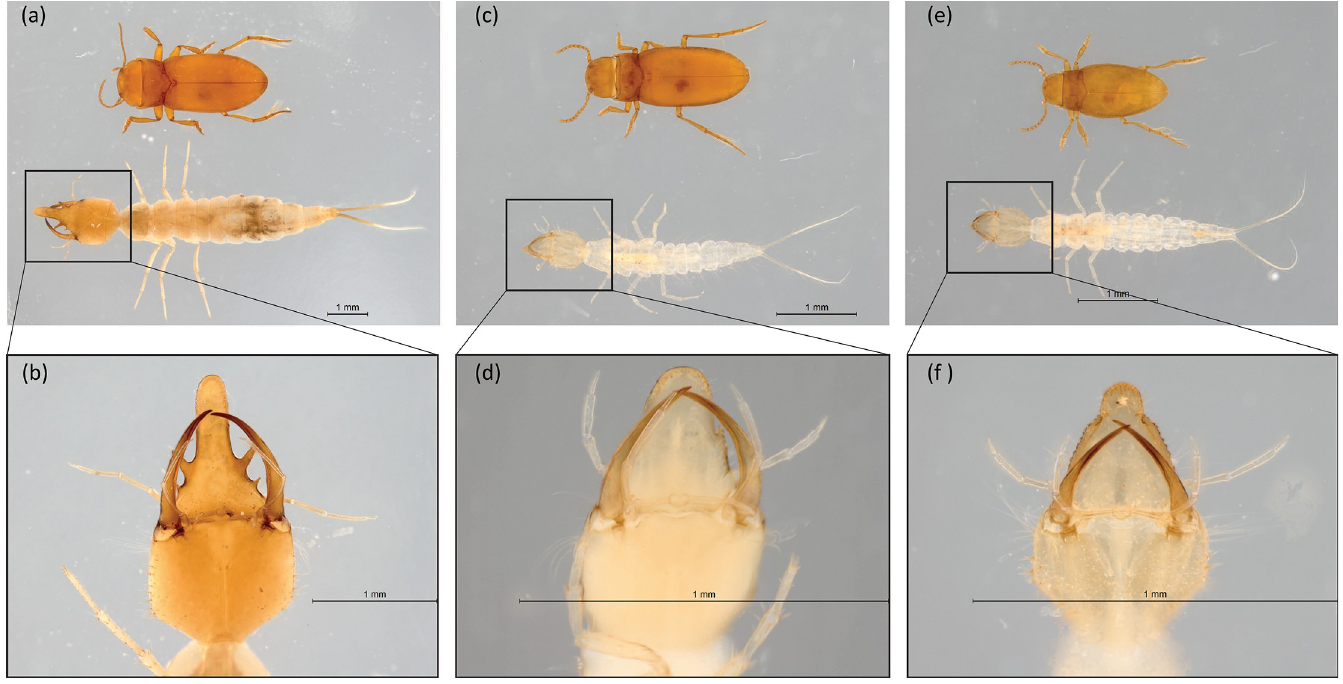
Fig 9. Comparisons between adult and larvae (whole body and head capsule) of P . macrosturtensis (a and b), P . mesosturtensis (c and d) and P . microsturtensis (e and f).